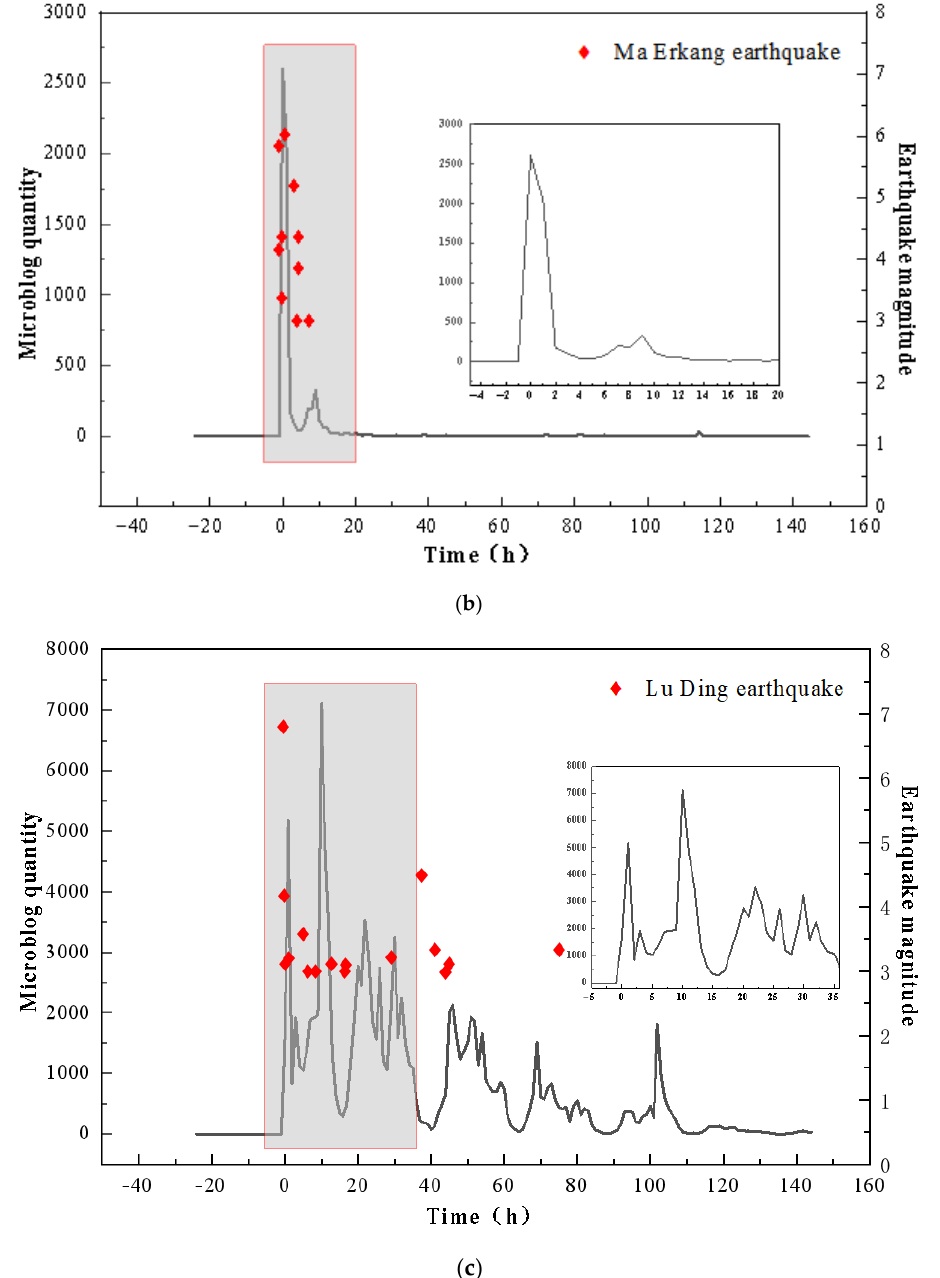
Figure 2. ( a ) Time series of Lushan earthquake. ( b ) Time series of Maerkang earthquake. ( c ) Time series of Luding earthquake.